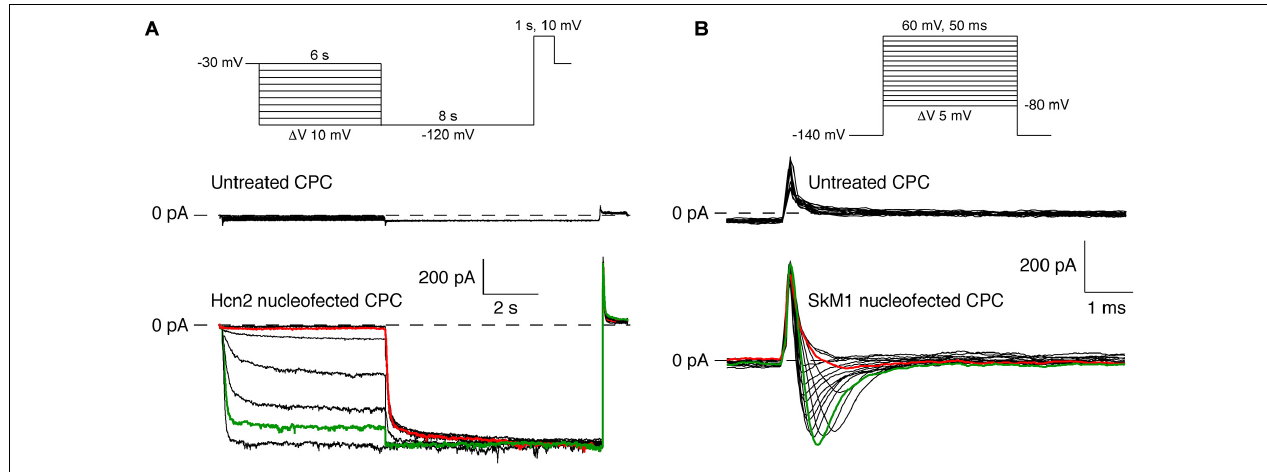
FIGURE 3 | Pilot experiments of Hcn2 and SkM1 currents measured at 36 ◦ C and room temperature, respectively, in single nucleofected CPCs. (A) Top panel, protocol used. Middle panel, recording of an empty CPC. Bottom panel, Hcn2-encoded “funny current” (at test potentials ranging from –30 to –120 mV) in an Hcn2 nucleofected CPC. (B) Top panel, protocol used. Middle panel, recording of an empty CPC. Bottom panel, skeletal fast sodium current (at test potentials ranging from –50 to +20 mV) in a SkM1 nucleofected CPC. SkM1 was measured from a holding potential of –140